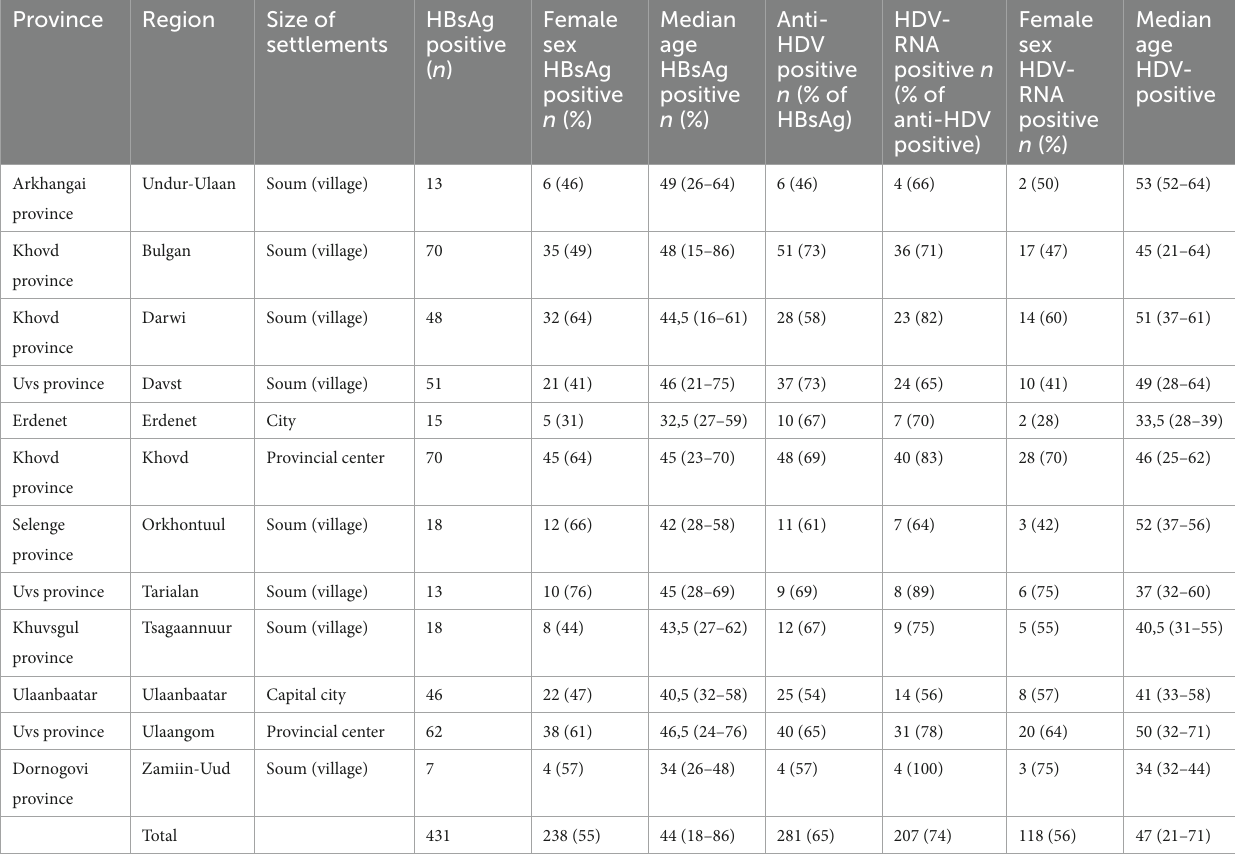
TABLE 1 HDV prevalence among the adult population of rural areas of